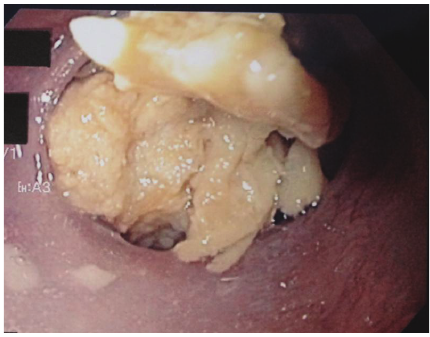
Figure 2: Food impacted in the distal esophagus. Table 2: 100 patients admitted to hospital with impacted food in the oesophagus.